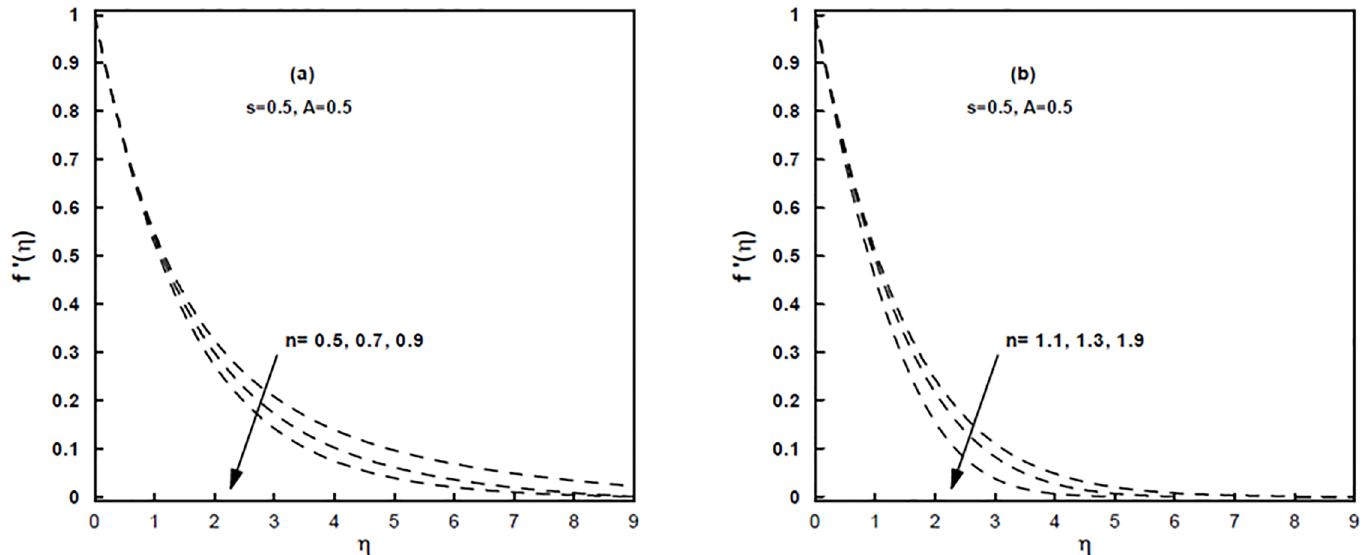
Fig 1. (a,b), The velocity profiles for different values of the power-law index n .